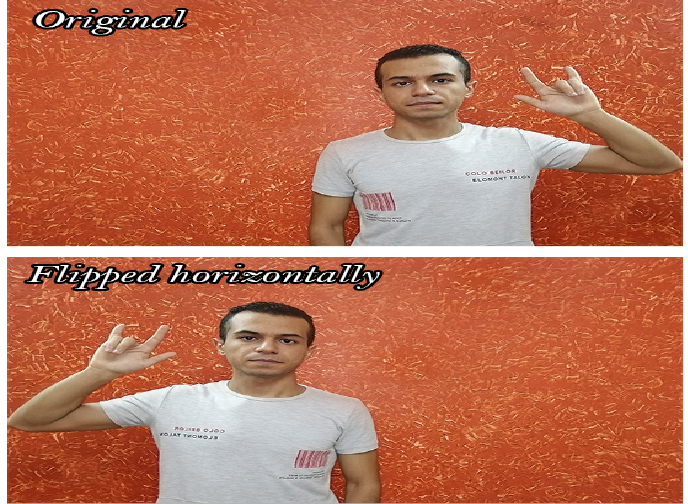
Figure 2. Flip horizontal augmentation.